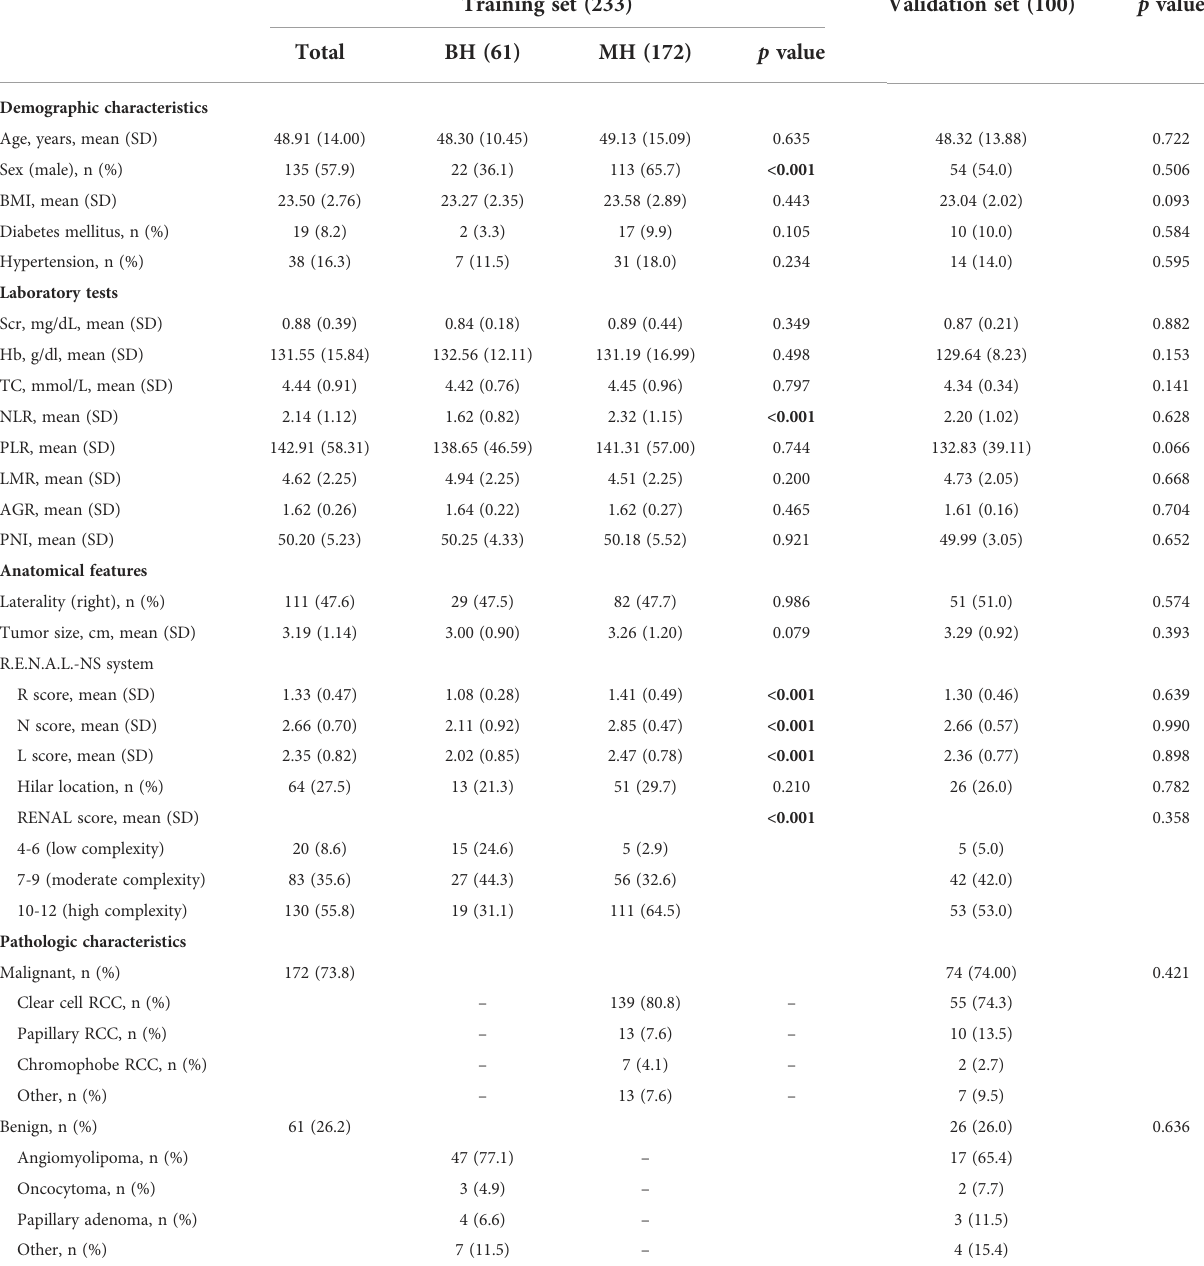
TABLE 1 Demographic and clinical characteristics of the training and validation sets in BH vs. MH